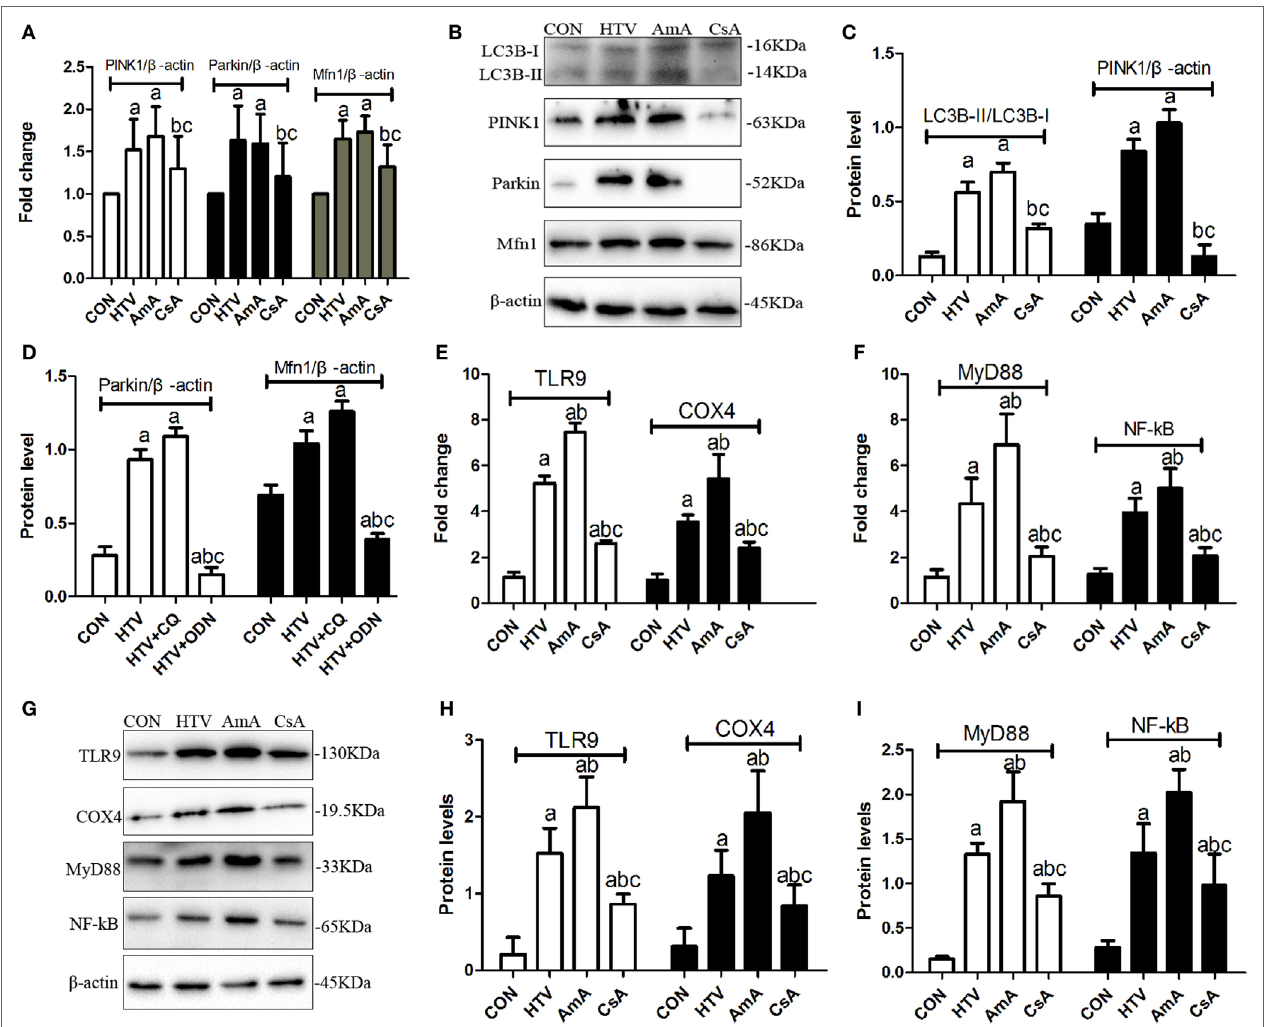
FigUre 7 | The expression levels of microtubule protein light chain 3 (LC3B), PTEN inducing putative kinase 1 (PINK1), Parkin, mitofusin 1 (Mfn1), toll-like receptor (TLR) 9, cytochrome c oxidase 4 (COX4), myeloid differentiation factor 88 (MyD88), and nuclear factor (NF)- κ B in lung tissues from animals with spontaneous breathing (CON) or mechanical ventilation at high tidal volume (HTV) with saline, antimycin A (AmA) or cyclosporine A (CsA). (a) Levels of PINK1, Parkin, and Mfn1 mRNA. (B) Levels of LC3B, PINK1, Parkin, and Mfn1 protein by Western blot. (c) Relative expression of LC3B-II/LC3B-I and PINK1 protein. (D) Relative expression of Parkin and Mfn1 protein. (e) Levels of TLR9 and COX4 mRNA. (F) Levels of MyD88 and nuclear factor- κ B (NF- κ B) mRNA. (g) Levels of TLR9, COX4, MyD88, and NF- κ B protein by Western blot. (h) Relative expression of TLR9 and COX4 protein. (i) Relative expression of MyD88 and NF- κ B protein. Fold expression for target genes was normalized to that measured for the β -actin gene. Both of these experiments were in triplicate. a P < 0.05 vs. CON group; b P < 0.05 vs. HTV group; and c P < 0.05 vs. AmA